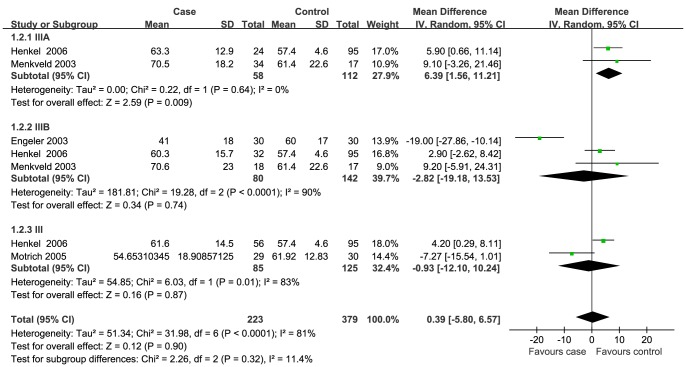
Forest plot showing the meta-analysis outcomes of the effect of CP/CPPS on sperm total motility.